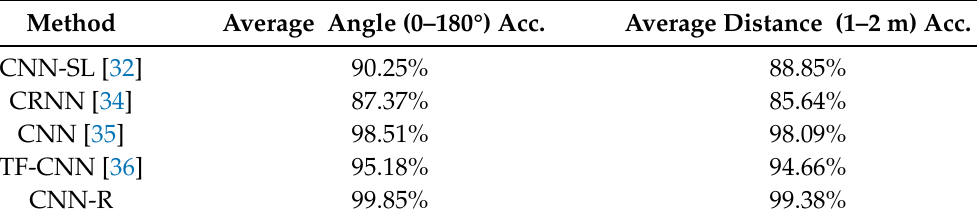
Table 12. Comparative results of angle and distance estimation based on the multi-channel impulse